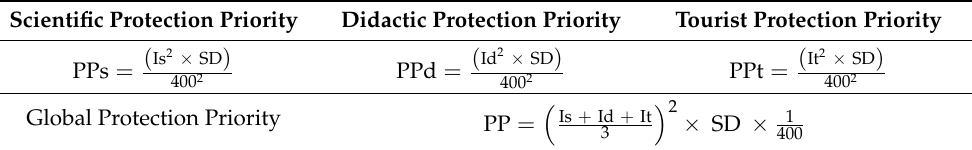
Table 4. Detail that the equations used to obtain the global protection priority and the protection priority in their different scientific, didactic, and tourist aspects [17]. Interpretation of Pp: very high (400–113), high (112–17), medium (16–1), and low (<1). Scientific Protection